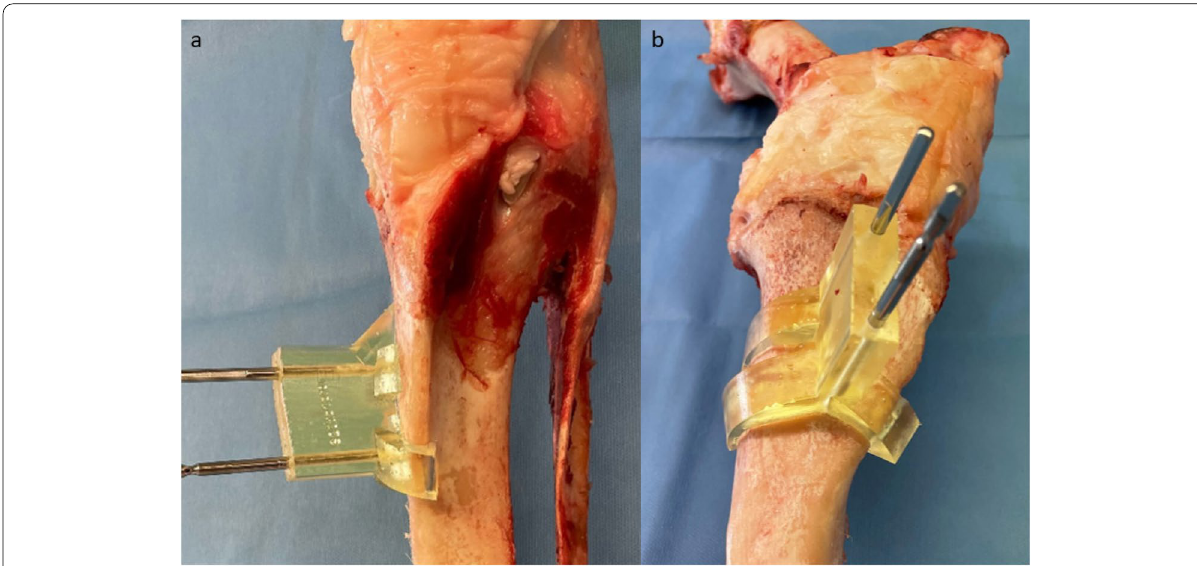
Fig. 4 Tibial surgical site with fitted guide. a shows the first guide fitted to the medial proximal tibia, fixed with Schanz pins in frontal view. b demonstrates a closer anteromedial view of the anatomical shaped guide